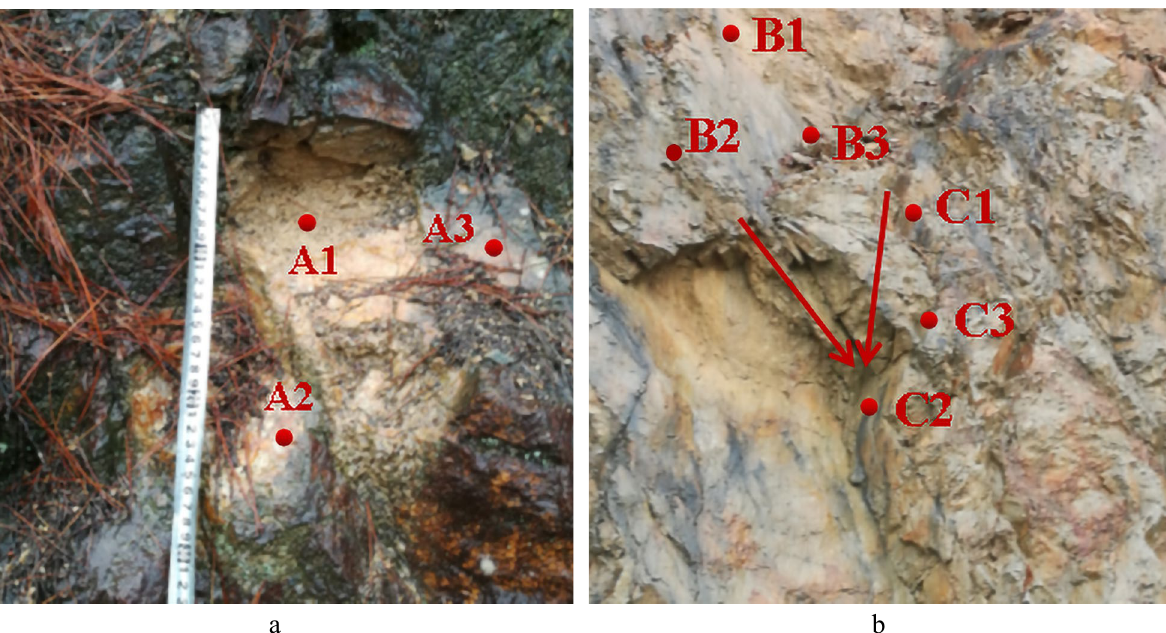
Figure 10. Coordinate points of several typical locations on the slopes of the Suichang Gold Mine Geopark. ( a ) Structural plane of the single-slip surface. ( b ) Structural plane of the double-slip